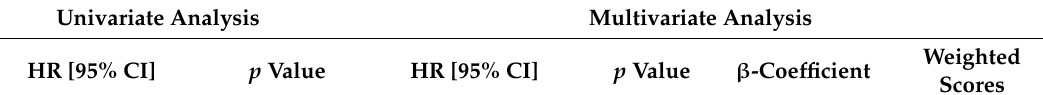
(Table 2). Integer scores were assigned values of − 1, 1 and 2 for the β -coefficient associated with HRs of − 0.882, 0.810 and 1.617, respectively. A composite score based on the strongest β -coefficients in the final model (Table 3) was generated: one point was attributed to RVEDTD ≥ 4.2 cm, one point was attributed to PASP ≥ 103 mm Hg and minus one point was attributed to TAPSE ≥ 1.8 cm.